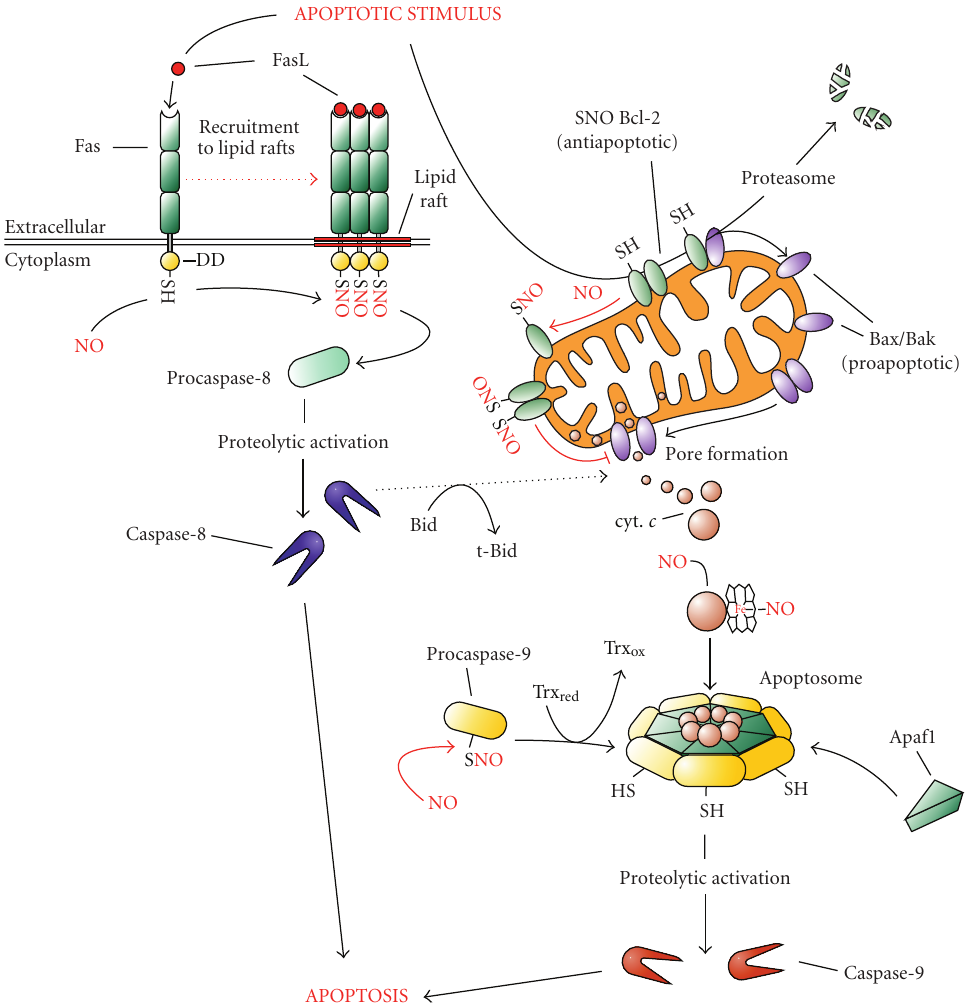
Figure 5: E ff ects of NO and nitrosative stress on apoptosis. NO-mediated e ff ect on cell viability and death has been carefully characterized in the last years. For example, Bcl-2 has been reported to be S -nitrosylated and thus modified to be stabilized and not degraded by the Ubiquitin/proteasome system. Cytochrome c has been also indicated to undergo S -nitrosylation in order to bind Apaf1 and procaspase-9 and promote the assembling of the apoptosome. Zymogen procaspase-9, and the executioner pro-caspase3, remain in a quiescent (inactive) form since they are S -nitrosylated in their catalytic cysteine residue in order to avoid unwanted activation of death program. Upon apoptotic stimulus, Trxs are able to denitrosylate caspases, thereby allowing their proteolytic activation and the progression of the apoptotic events downstream it. Recently, it has been also highlighted that the recruitment of the death receptor Fas to lipid rafts of plasma membrane upon binding to its ligand (FasL) is enhanced by S -nitrosylation of Cys 304 of its cytoplasmic domain (DD, death domain). In this case S - nitrosylation positively a ff ects the execution of apoptosis that takes place directly via the caspase-8-initiated extrinsic route or can synergize with the mitochondrial pathway through the proteolytic activation of the proapoptotic protein Bid in its truncated form